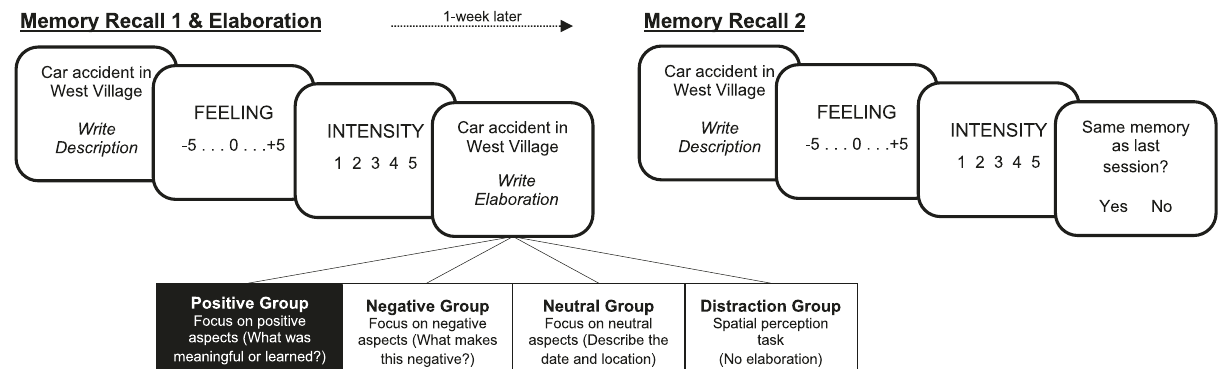
Fig. 1 Timeline for experiment 1. Participants fi rst wrote about and emotionally rated 12 negative autobiographical memories. Depending on random group assignment, they either focused on the positive (Positive group), negative (Negative group), or neutral aspects of each memory (Neutral group), or performed a spatial perception task (Distraction group). To examine memory change, participants returned 1-week later to write about and emotionally rate their memories